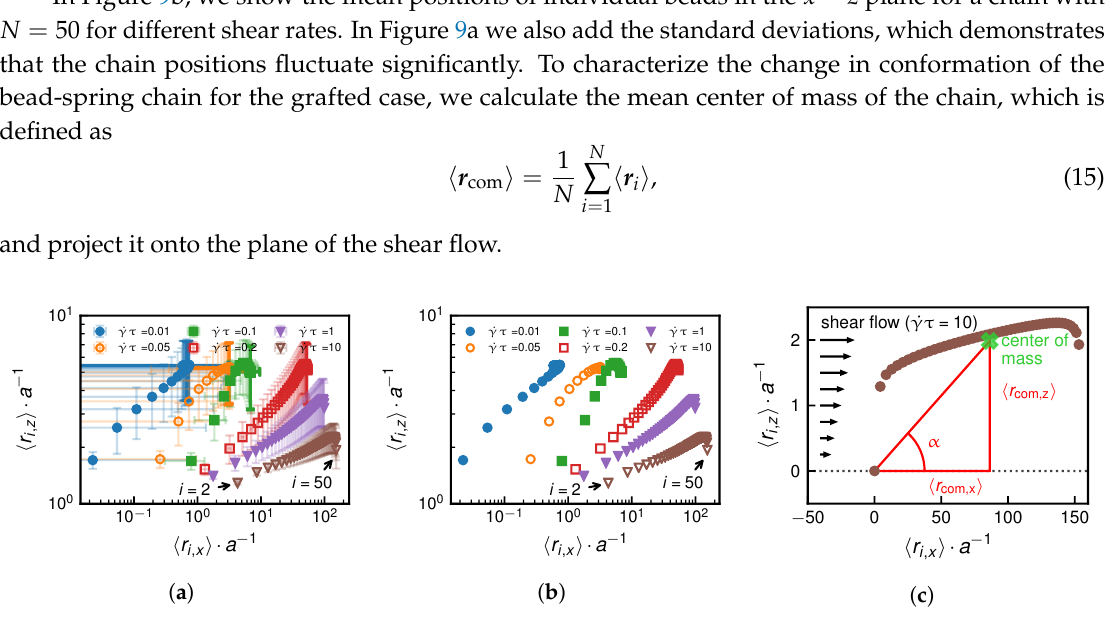
Figure 9. Grafted scenario: Subfigure ( a ) depicts the shear-rate-dependent mean position of individual beads of a chain with N = 50 in the x − z plane together with the respective standard deviations. Subfigure ( b ) only shows the mean positions. The mean center of mass coordinates in x and z direction, (cid:104) r com,x (cid:105) and (cid:104) r com,z (cid:105) , are exemplarily shown for the shear rate ˙ γ = 10 τ − 1 in subfigure ( c